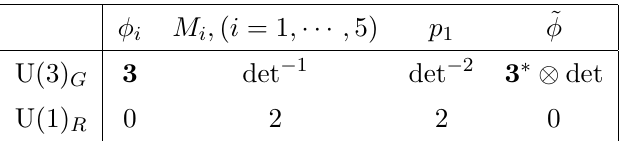
Table 10 . Field contents of dual U(3) GLSM for X 2 ; 5